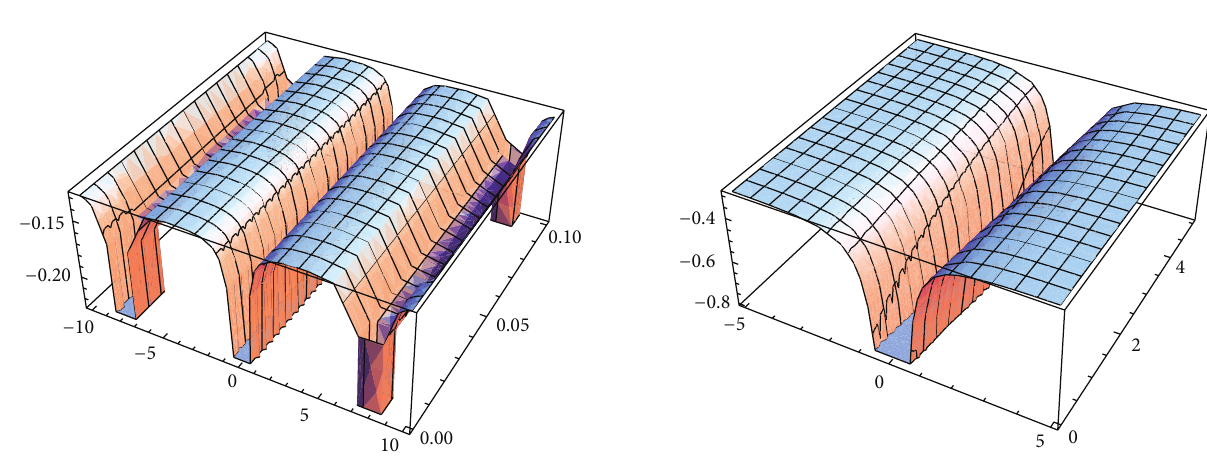
Figure 3: Travelling waves solutions (35) are plotted: dark solitary